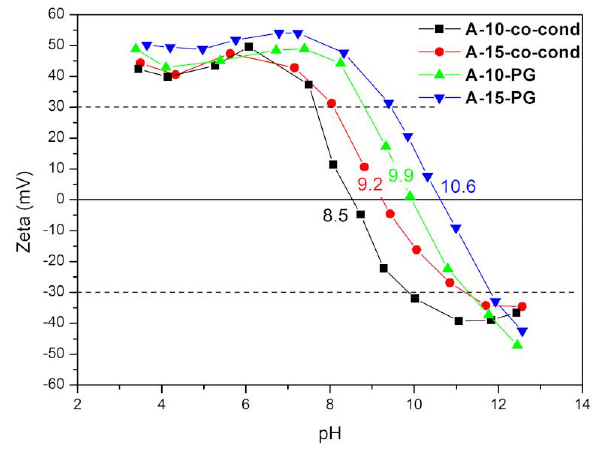
Figure 5. Zeta potential of the samples measured as a function of pH.